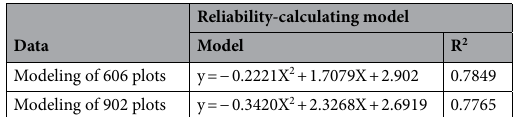
Table 5. Productivity prediction model of multi-stage reserved and increase eucalyptus sample plots.